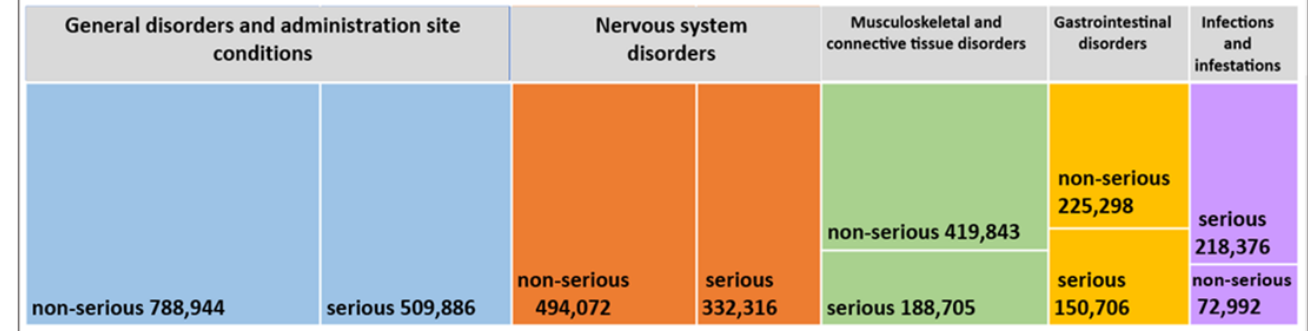
Figure 1. The number of Individual Case Safety Reports (ICSRs) on serious and non-serious suspected adverse reactions of COVID-19 vaccines authorized in the European Union, divided into groups of diagnoses largely represented by ICSRs in EudraVigilance European Database for Suspected Adverse Drug Reaction Reports (EDSADRR) (data on 17 September 2022, created by the authors based on statistical data [42]).